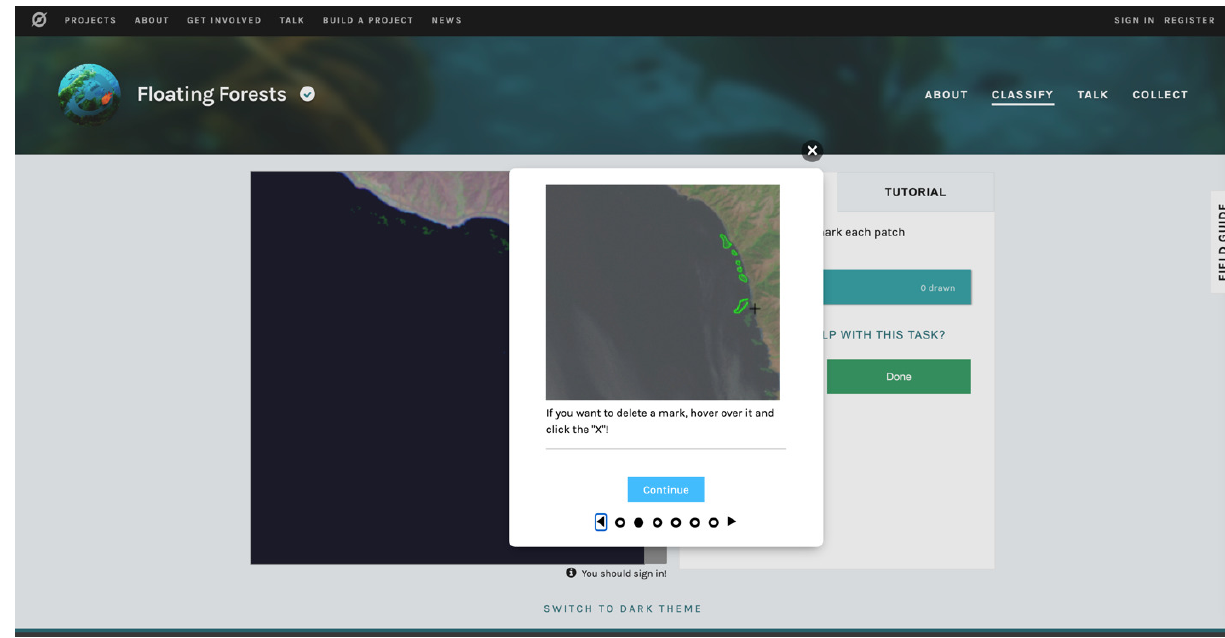
Figure 1: Floating Forests instructional direction, showing how to highlight patches of kelp forest. Screenshot from